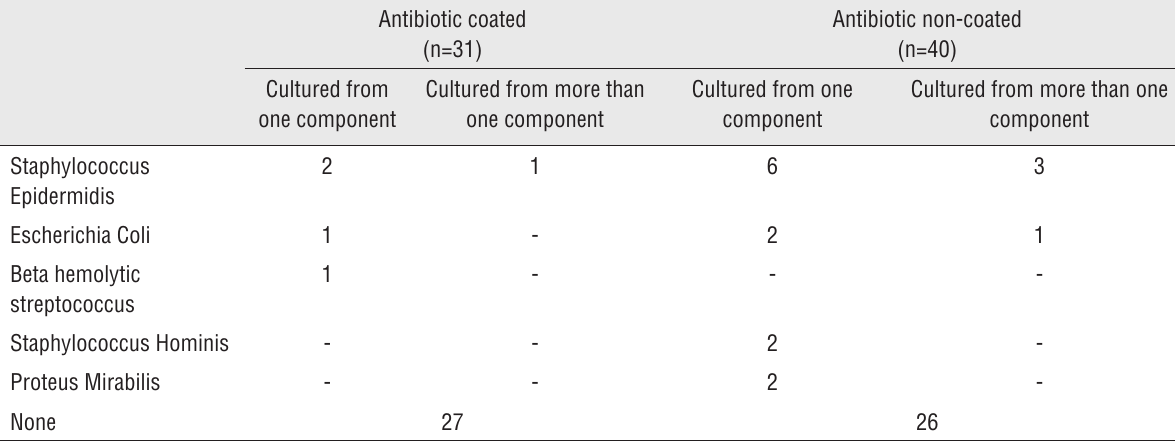
Table 2 - Organisms cultured from uninfected penile prostheses during the revision